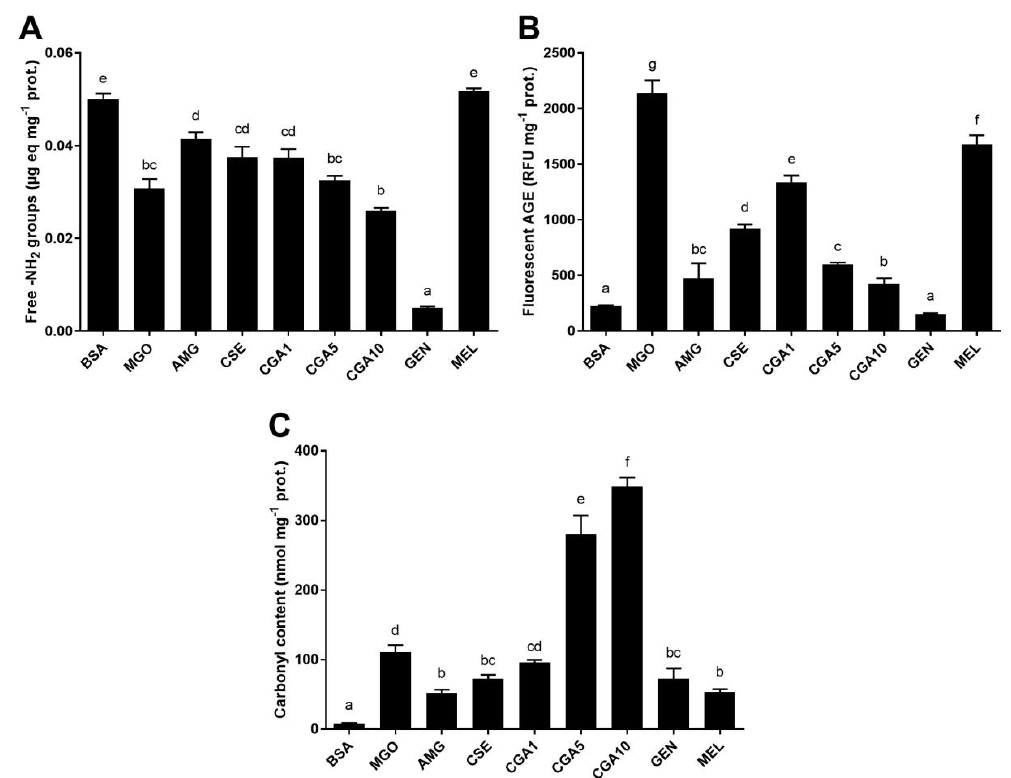
Figure 4. Contents of free amino groups ( A ), fluorescent AGE ( B ), and protein carbonyls ( C ) in the samples of the BSA-MGO (methylglyoxal) glycation system (72 h incubation, 37 ◦ C, pH 7.4) BSA: negative control; MGO: BSA + methylglyoxal; AMG: BSA + methylglyoxal + aminoguanidine; CSE: BSA + methylglyoxal + CSE (12,5 mg mL − 1 ); CGA1: BSA + methylglyoxal + 1 mmol L − 1 CGA; CGA5: BSA + methylglyoxal + 5 mmol L − 1 CGA; CGA10: BSA + methylglyoxal + 10 mmol L − 1 CGA; GEN: BSA + methylglyoxal + 5 mmol L − 1 genistein; MEL: BSA + methylglyoxal + 5 mmol L − 1